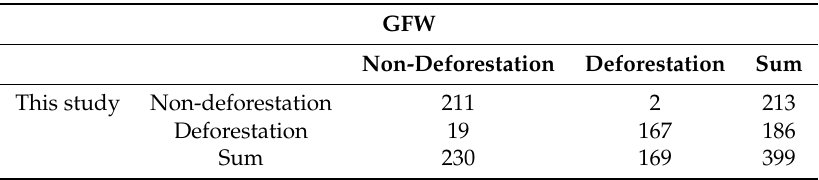
Table 4. Comparison between GFW annual forest cover change map and the detection result of the proposed